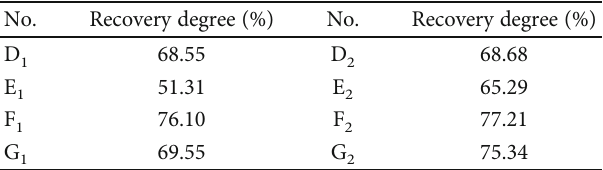
Table 3: Permeability recovery of di ff erent